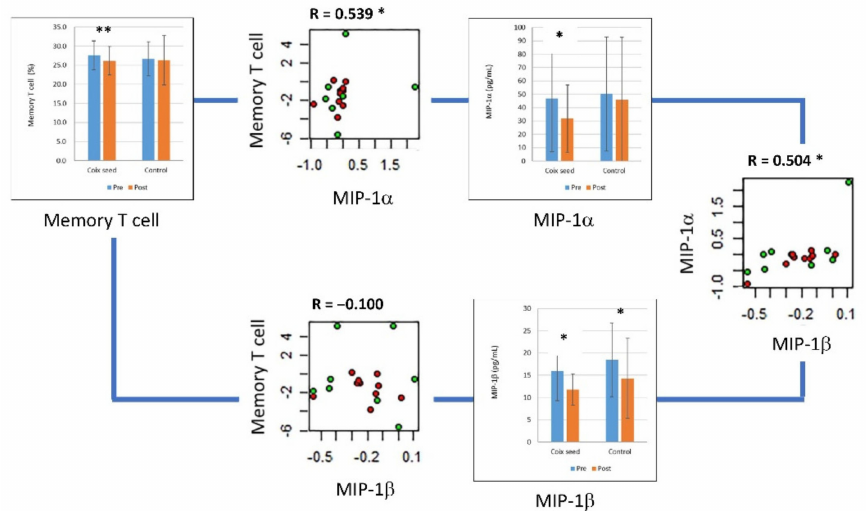
Figure 3. MIP-1 α , MIP-1 β , and their correlation with the peripheral memory T cell percentage. The plasma concentration of MIP-1 α and MIP-1 β significantly decreased after coix seed consumption. The change in MIP-1 α showed a significant correlation with the change in memory T cell percentage. The changes in MIP-1 α and MIP-1 β were significantly correlated. In the scatter plots, the red and green circles denote the coix seed consumption group and the control group, respectively. In the bar graphs, the blue and orange bars denote before (pre-intervention) and after (post-intervention) coix seed consumption, respectively. *, p < 0.05; **, p < 0.01.